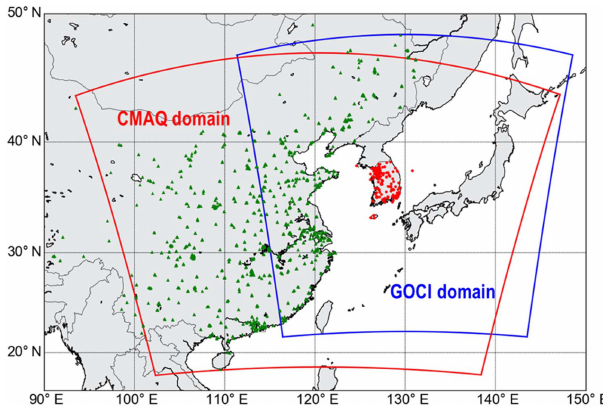
Figure 5. Domains of the CMAQ model simulations (red line) and Geostationary Ocean Color Imager (GOCI) sensor (blue line). Green triangles and red dots represent the locations of ground-based monitoring sites in China and South Korea,